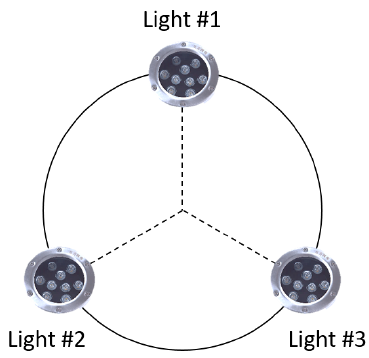
Figure 2. Distribution of the navigation lamps. Table 1. Specifications of the main equipment.